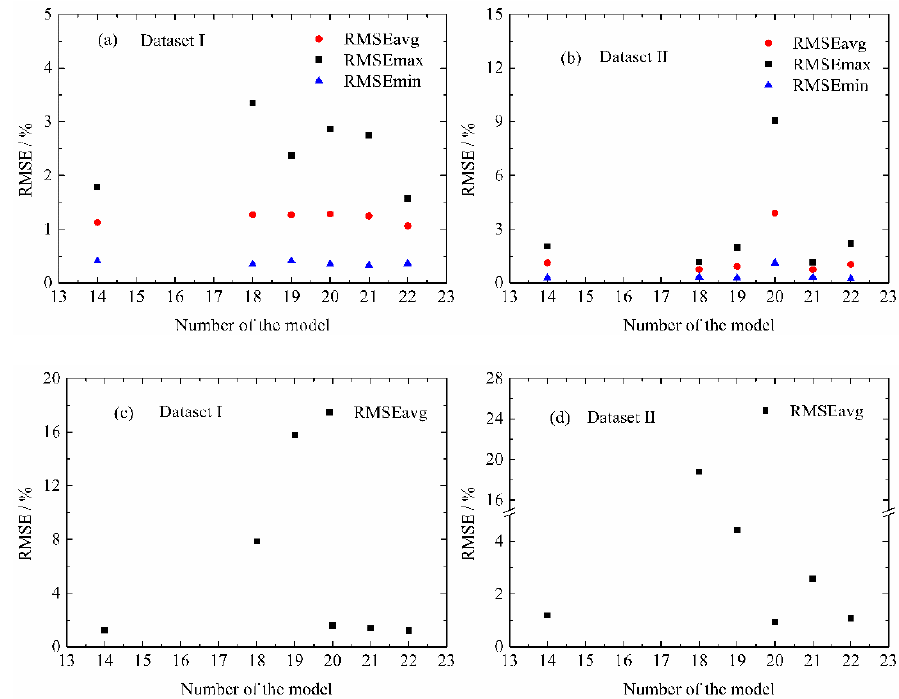
Figure 7. Prediction RMSE of the non-factor models for normal aging: ( a ) on the train dataset of Dataset I, ( b ) on the train dataset of Dataset II, ( c ) on the test dataset of Dataset I and ( d ) on the test dataset of Dataset II.